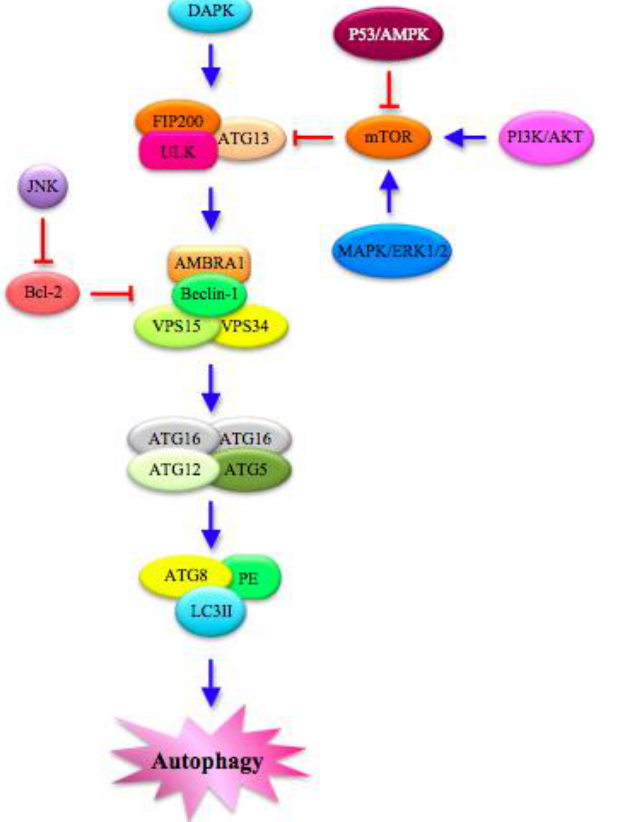
Figure 2. Autophagy pathway: Molecular features . Several proteins in the cytoplasm interact to regulate autophagy. The different steps of the process are modulated by MAPKs (Mitogen-Activated Protein Kinases), such as ERK (Extracellular Signal-Related Kinase) 1/2 and JNK (c-Jun N-terminal Kinase), which mainly act on the key negative regulator of autophagy mTOR (mammalian Target OF Rapamycin). mTOR is also controlled directly by PI3K/AKT (PhosphatidylInositol 3-Kinase/Protein Kinase B) and p53/AMPK (AMP-Activated Protein Kinase) signaling pathways. Moreover, DAPK (Death-Associated Protein Kinase) is implicated in the autophagic cascade, which starts with the formation of ULK (Unc-51-Like Kinase) complex, which is composed of FAK (Focal Adhesion Kinase)-family Interacting Protein of 200 kDa (FIP200), ULK and ATG13. In turn, ULK complex phosphorylates AMBRA1 (Activating Molecule in Beclin-1-Regulated Autophagy), leading to the activation of a complex that includes P-AMBRA1, Beclin-1, VPS (Vacuolar Protein Sorting) 15 and 34. The final steps are characterized by the assembly of ATG complexes made by ATG factors and autophagosome proteins. PE: Phosphatidyl